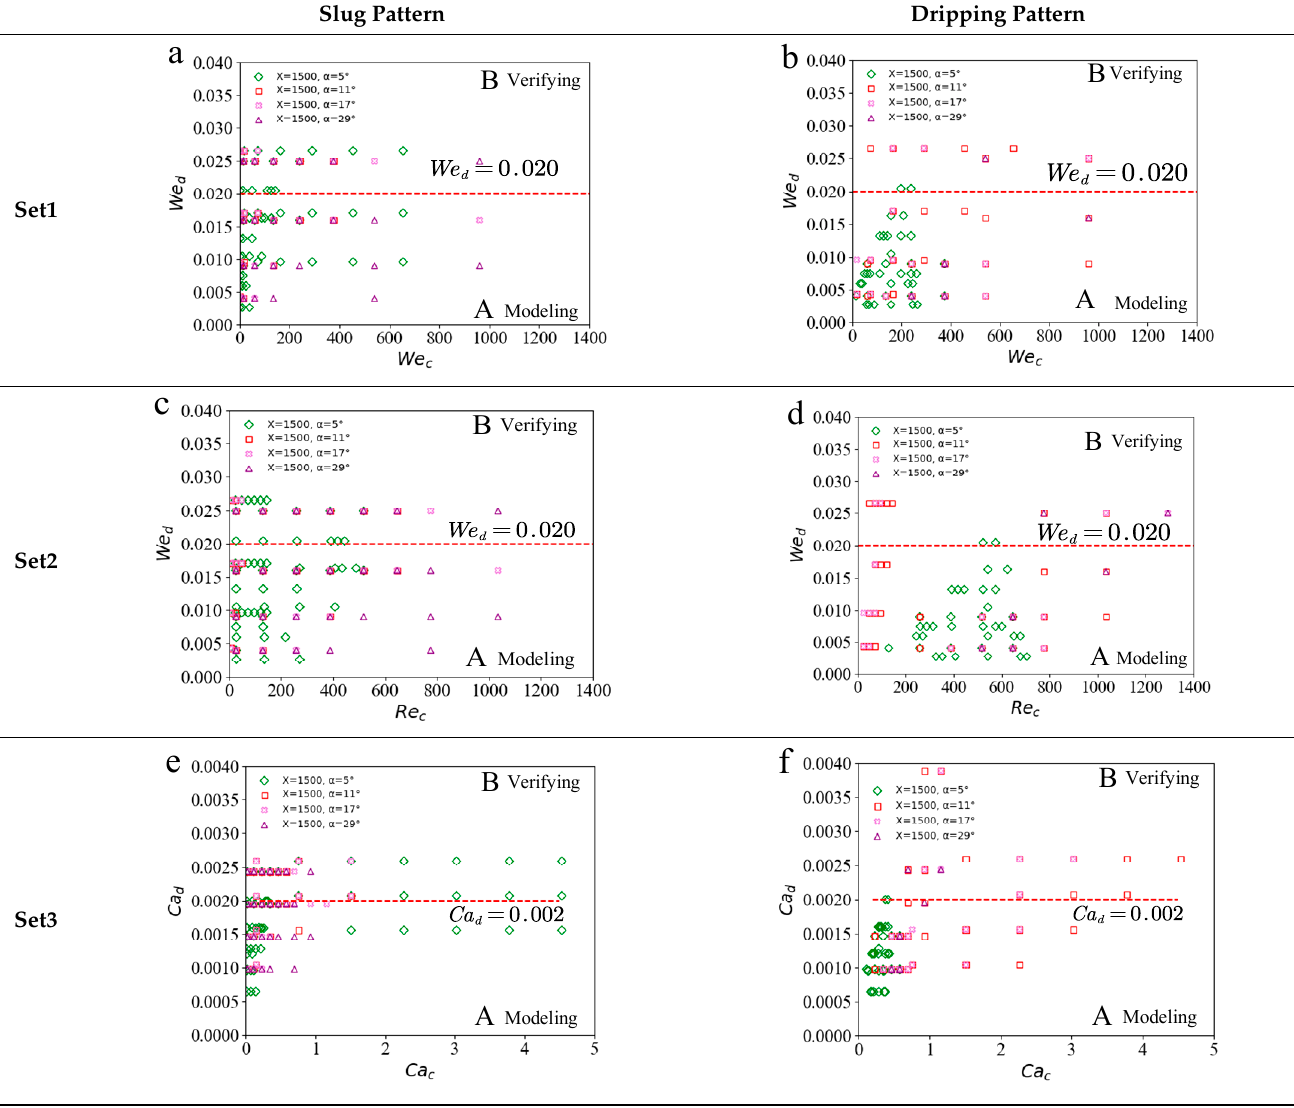
Table 5 is the data partition of slug and dripping patterns in three sets in Experiment 2. The partition line adopted the same parameters following it in Experiment 1. Table 5. Data partition of three sets with dimensionless numbers in Experiment 2: ( a ) slug in Set1, ( b ) dripping in Set1, ( c ) slug in Set2, ( d ) dripping in Set2, ( e ) slug in Set3, and ( f ) dripping in Set3.